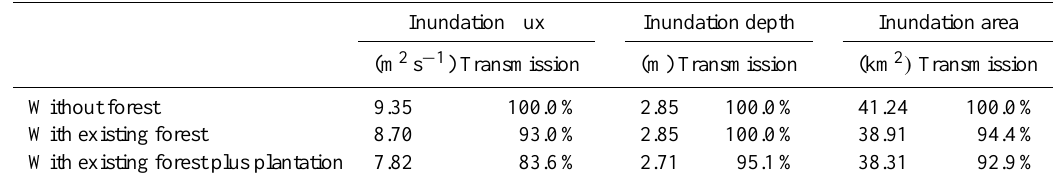
Table 5. The simulated damping performance of coastal forest in Yogyakarta.